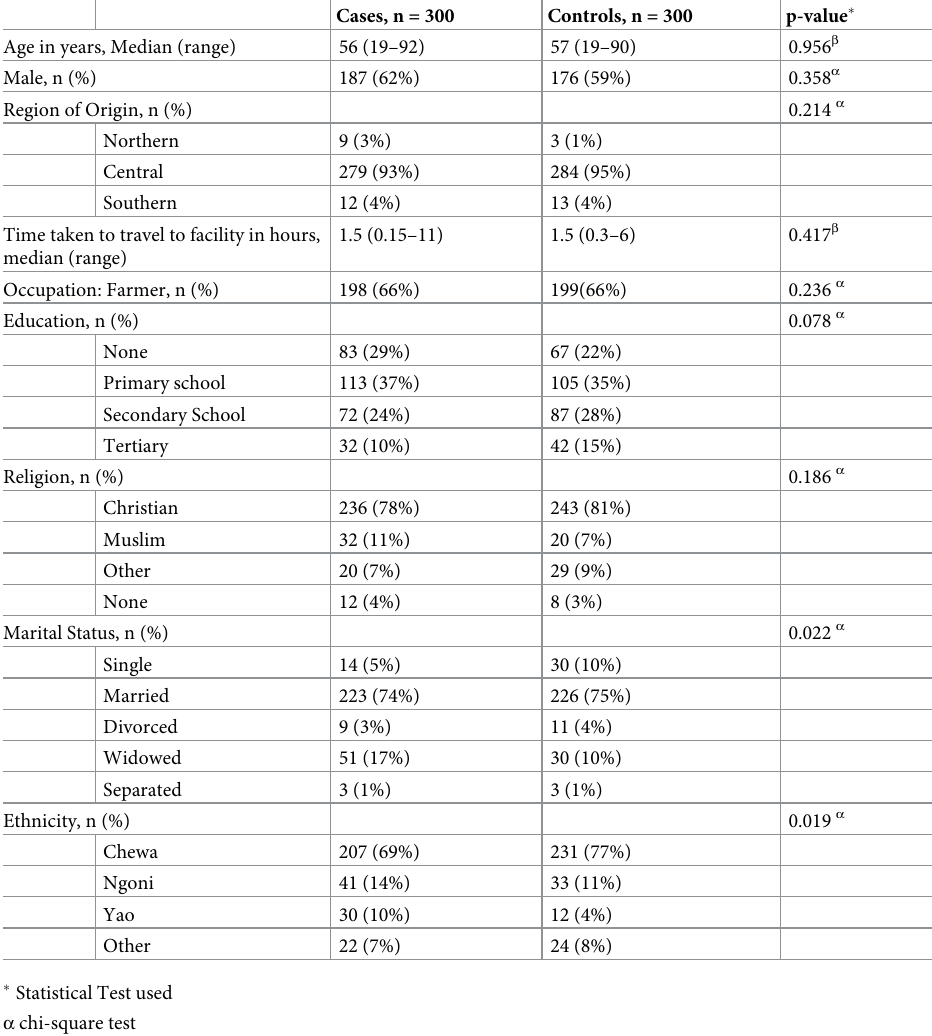
Table 1. Characteristics of participants enrolled in an ESCC case-control study in Lilongwe, Malawi. Cases, n = 300 Controls, n = 300 p-value